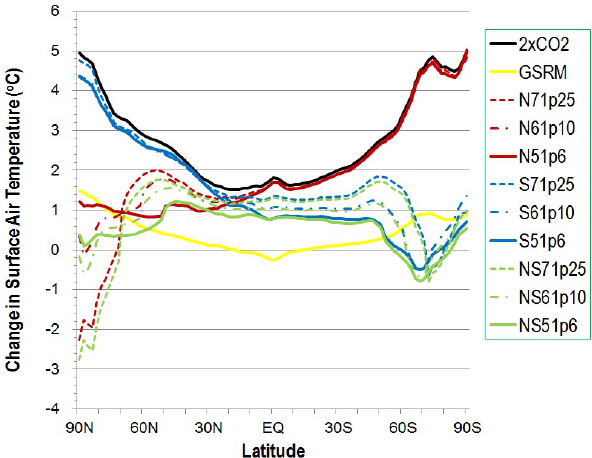
Fig. 4. Latitudinal variation of the temperature change (in Kelvins) remaining after imposing both a CO 2 doubling and the ten different extents of solar reduction considered in this paper. The plot is linear in latitude to provide improved resolution in high latitudes; an equal area weighting would show that counter-balancing of the warming in the simulations with polar reductions in solar radiation are more tightly restrained to the high latitudes where the reductions were imposed, and that a global reduction in solar radiation is required to return mid- and low-latitude temperature increases to near their 1 × CO 2 values.